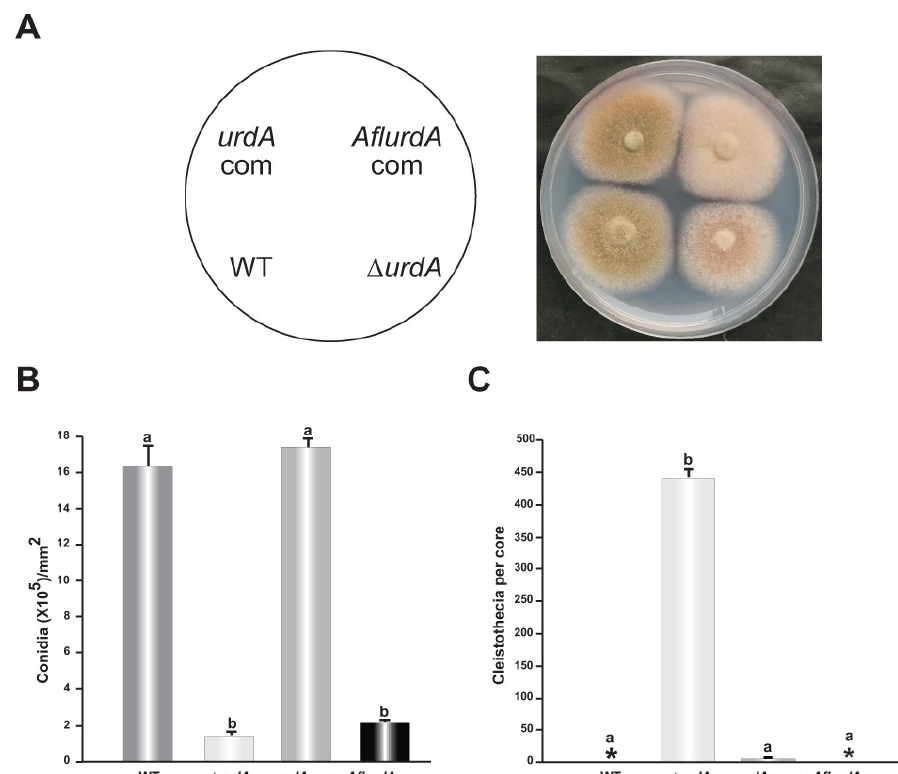
Figure 6. Heterologous complementation of A. flavus urdA in the A. nidulans Δ urdA strain. ( A ) A. nidulans and A. flavus urdA complementation strains ( urdA ‐com and AflurdA ‐com respectively), together with the Δ urdA and wild type (WT) control were point‐inoculated on GMM and incubated for 4 days at 37 °C in the light. ( B ) Quantification of conidia. Cores (7 mm diameter) were collected 1 cm from the colony center, homogenized in water and counted under the microscope. ( C ) Quantification of cleistothecia. Cores (16 mm diameter) were harvested 1 cm from the colony center and sprayed with 70% ethanol to improve visualization of fruiting bodies. Asterisks indicate not detected. Values are means of three replicates and error bars indicate standard errors. Different letters above the bar graphs represent significantly different values ( p ≤ 0.05).